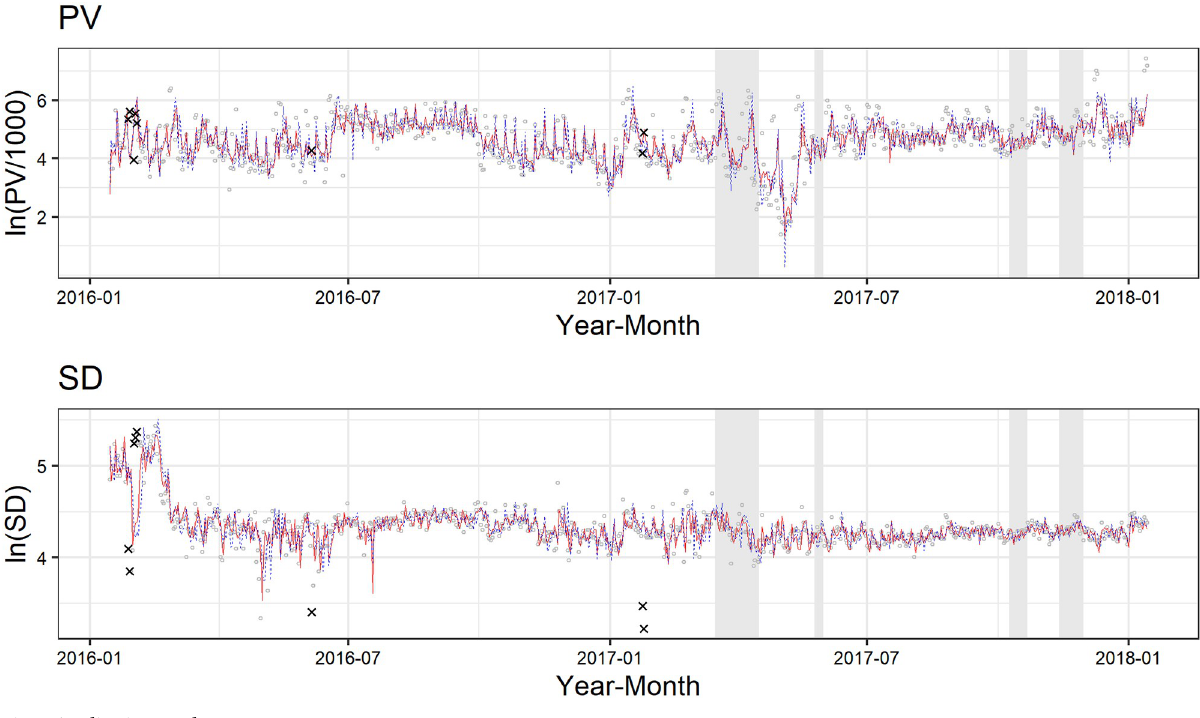
Fig 9. Application